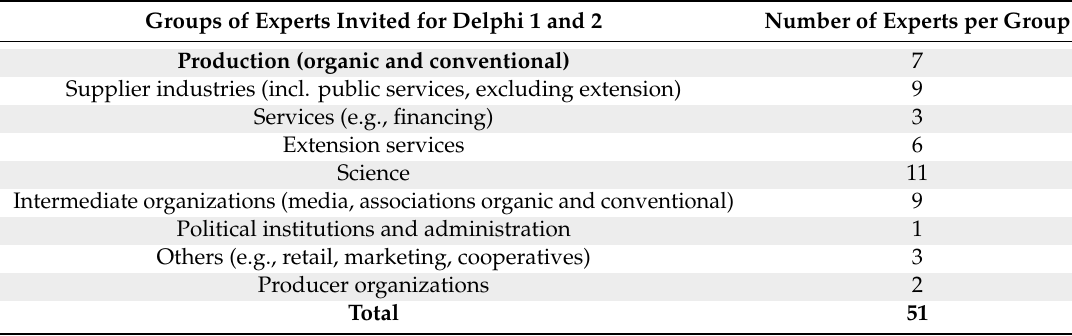
Table 2. Sampling of invited experts for Delphi rounds 1 and